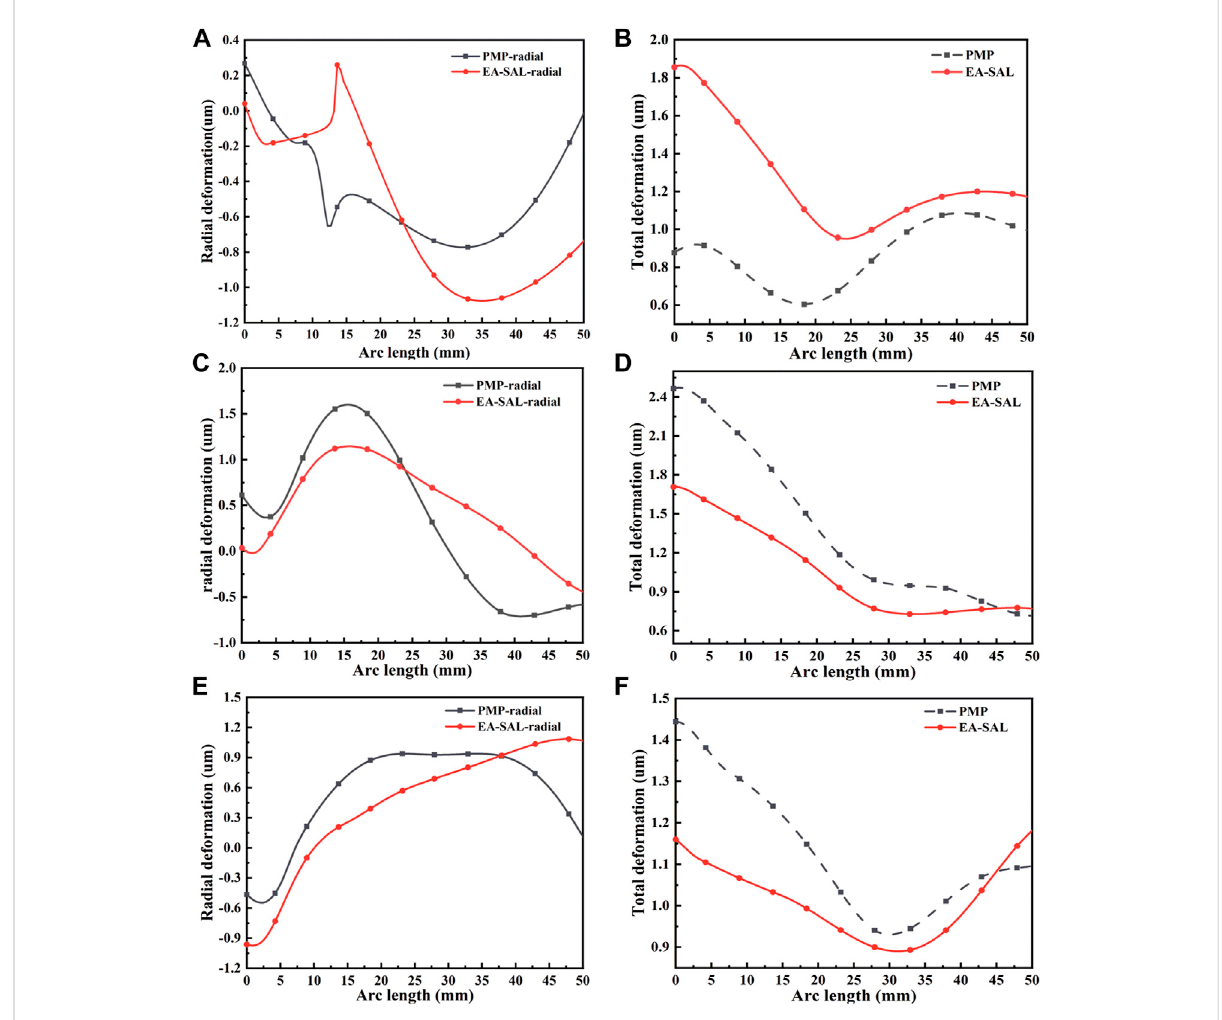
FIGURE 11 The top deformation curve under pressure load at different spindle positions [ (A,B) -60 ° ; (C,D) -180 ° ; (E,F) -240 °